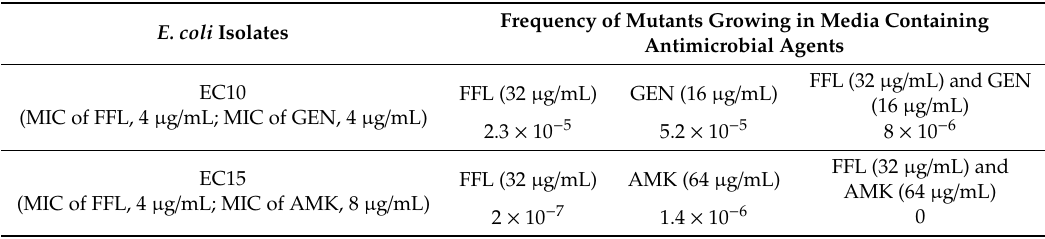
Table 3. Mutation frequency of E. coli isolates with the florfenicol and aminoglycosides combination. E. coli